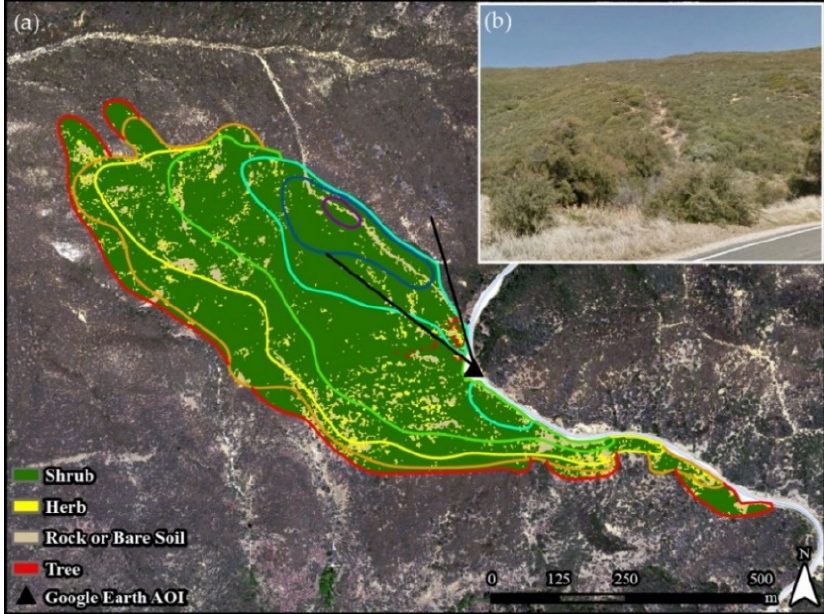
Figure 5. Thomas sequence 3 growth form composition. Figure depicts the largely homogenous fuel distribution at the Thomas Fire sampling areas. ( a ) Fire front positions overlaid on growth form map and National Agriculture Imagery Program (NAIP) orthoimagery. ( b ) Prefire Google Earth image overlooking portion of Thomas sequence 3.